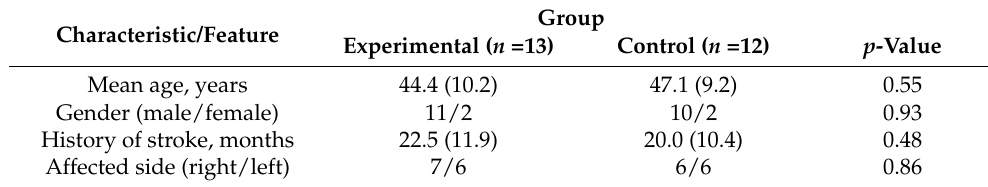
Table 1. Participant demographic characteristics and clinical features between the